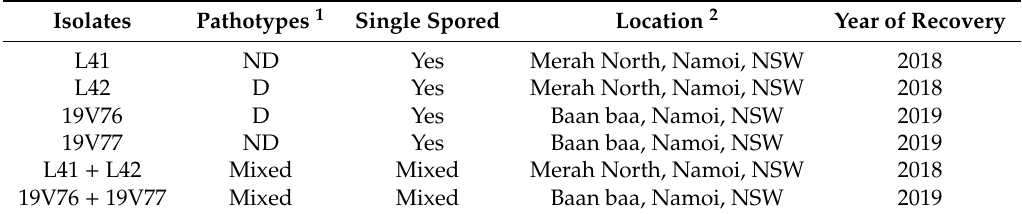
Table 3. A brief description including pathotypes, single-spored status, location and year of recovery of V. dahliae isolates from cotton used in pathogenicity